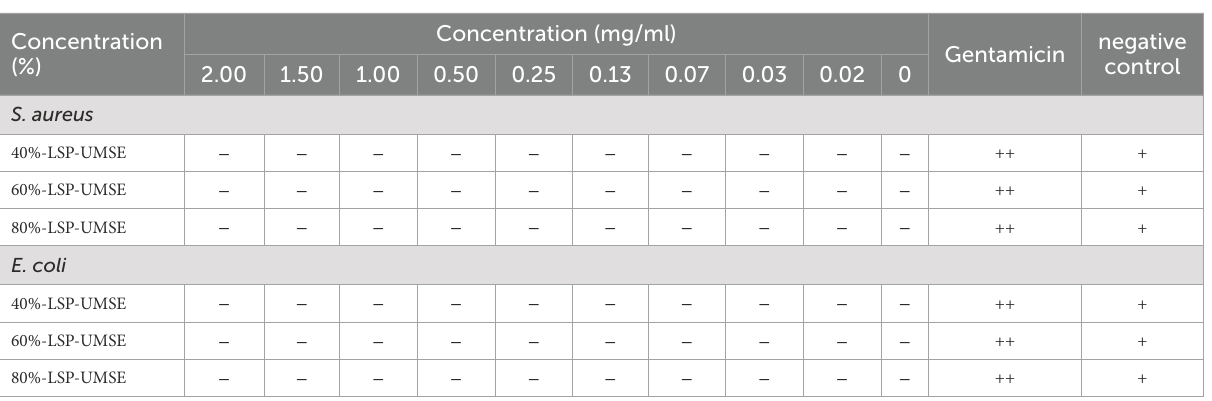
TABLE 3 Effect of LPS on S. aureus and E. coli.